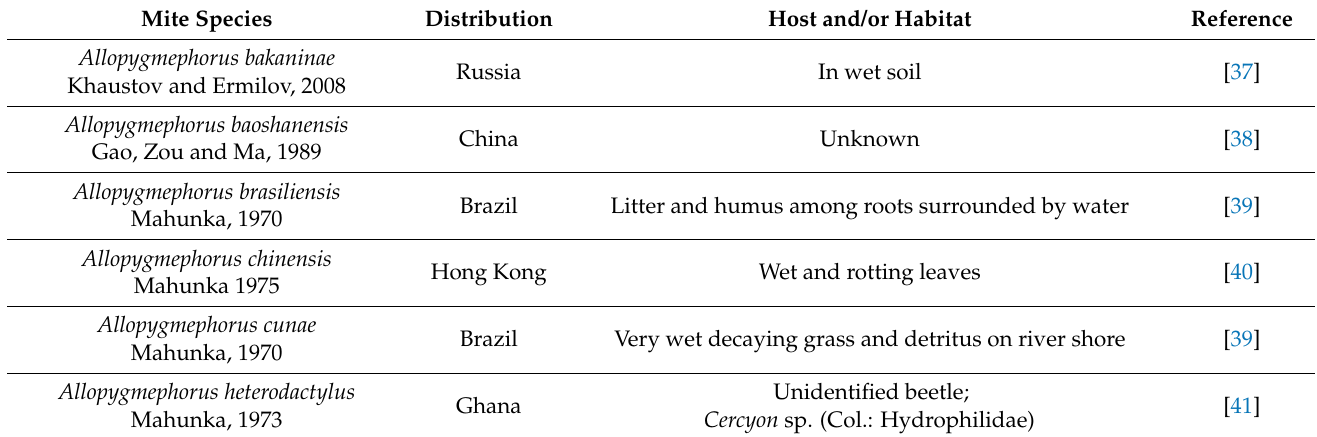
Table 1. Information on the distribution and host and/or habitat associations of all known species of Allopygmephorus